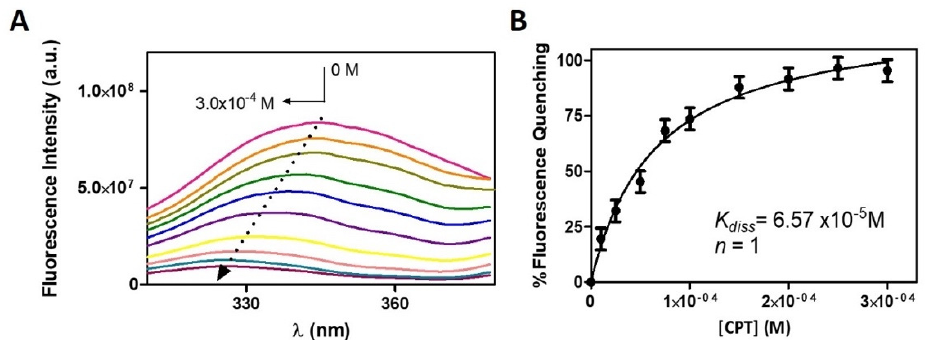
Figure 8. ( A ) Fluorescence spectra of HSA (2.0 × 10 − 6 M) in the presence of increasing CPT concentrations (0 to 3.0 × 10 − 4 M) at 37 °C. ( B ) Binding isotherm plot of CPT-HSA. The non-linear fit to the experimental data was made using Equation (6) and allowed to determine the dissociation constant (K diss ) and the number of binding sites (n).